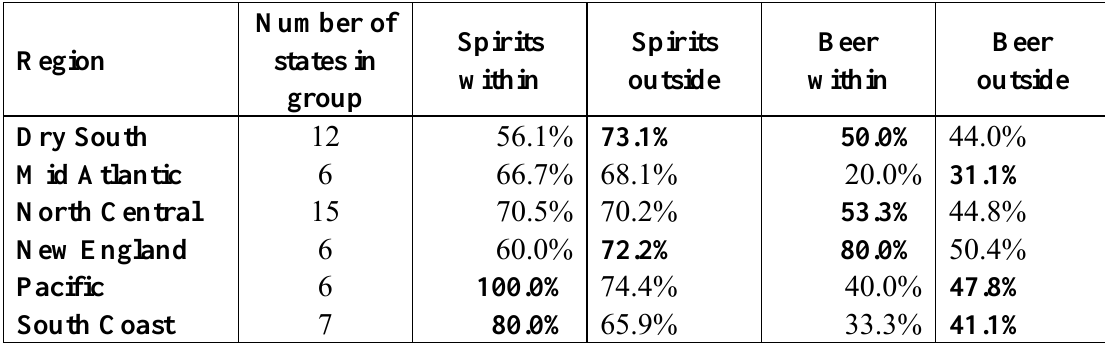
Table 2. Proportion of Granger Causality Tests showing significant relationships between states within each state grouping compared to states outside the grouping for states in each group. Significant relationships indicate predictive value of one state’s spirits or beer series on another state’s